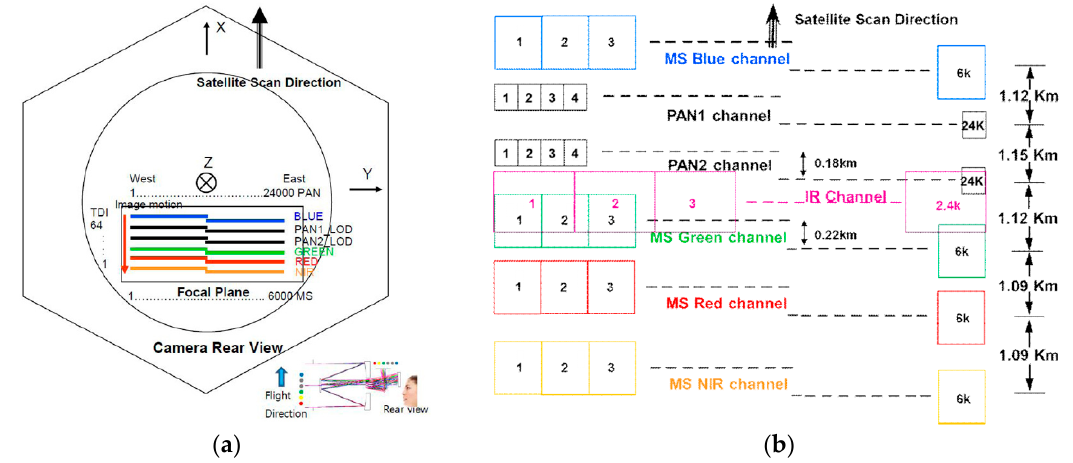
Figure 1. Kompsat-3A AEISS-A (Advanced Electronic Image Scanning System-A) sensor configuration. ( a ) Camera rear view; ( b ) CCD array configurations.